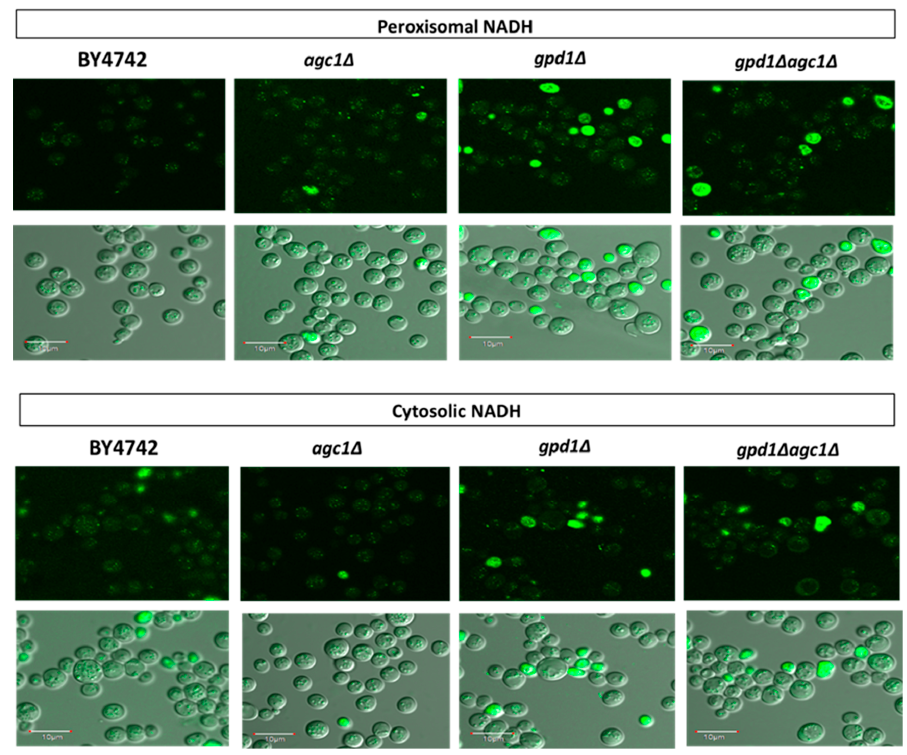
Figure 2. Deletion of AGC1 increases peroxisomal NADH signals but decreases cytosolic NADH signals in the stationary phase. Yeasts containing peroxisomal and cytosolic NADH sensor plasmids were grown in a synthetic deficient (SD) medium plate supplemented with 2% glucose for five days and then taken for visualizing NADH signals with confocal fluorescence microscopy. The small punctate green fluorescence signals represented NADH localizing in peroxisomes. Note that deletion of GPD1 showed similar e ff ects as deletion of AGC1 , and deletion of AGC1 in gpd1 ∆ cells also restored cytosolic NADH signals. In addition, cytosolic NADH signals induced by peroxisomal NADH sensor plasmids and peroxisomal NADH signals induced by cytosolic NADH sensor plasmids were